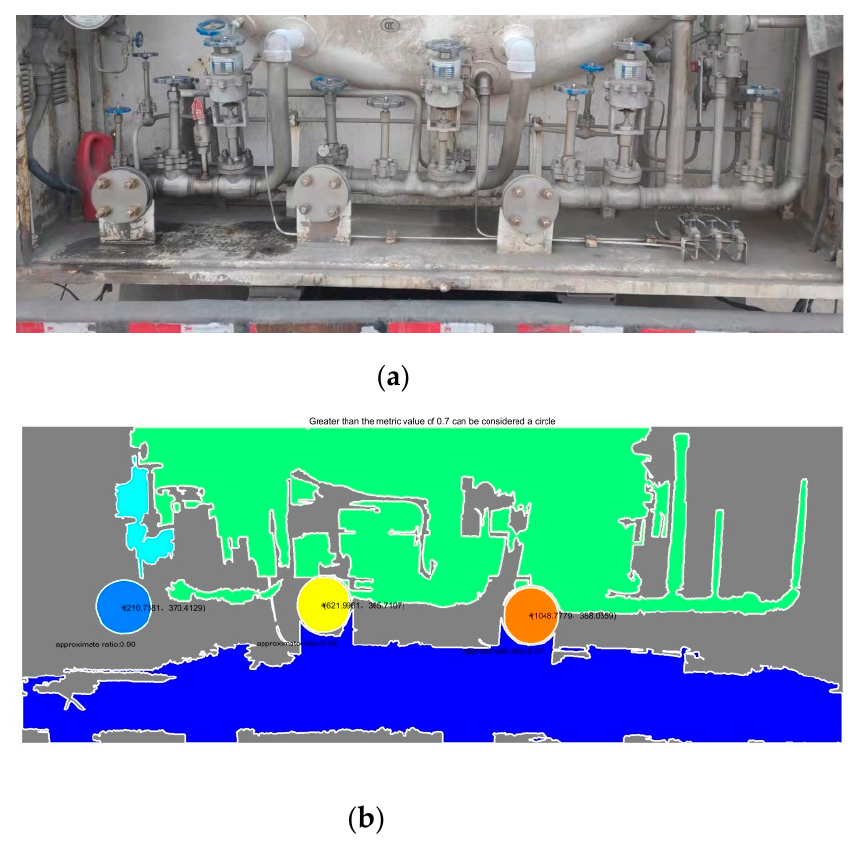
Figure 13. On-site tank car A. ( a ) Flange practicality picture. ( b ) Detection results of ( a ).